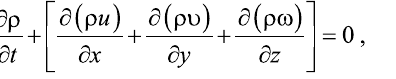
All beetles were anesthetized with ether. Their hind wings were cut out with a scalpel, and a 1 mm 2 area was sliced from the wing base, folded zone, and the posterior part of the